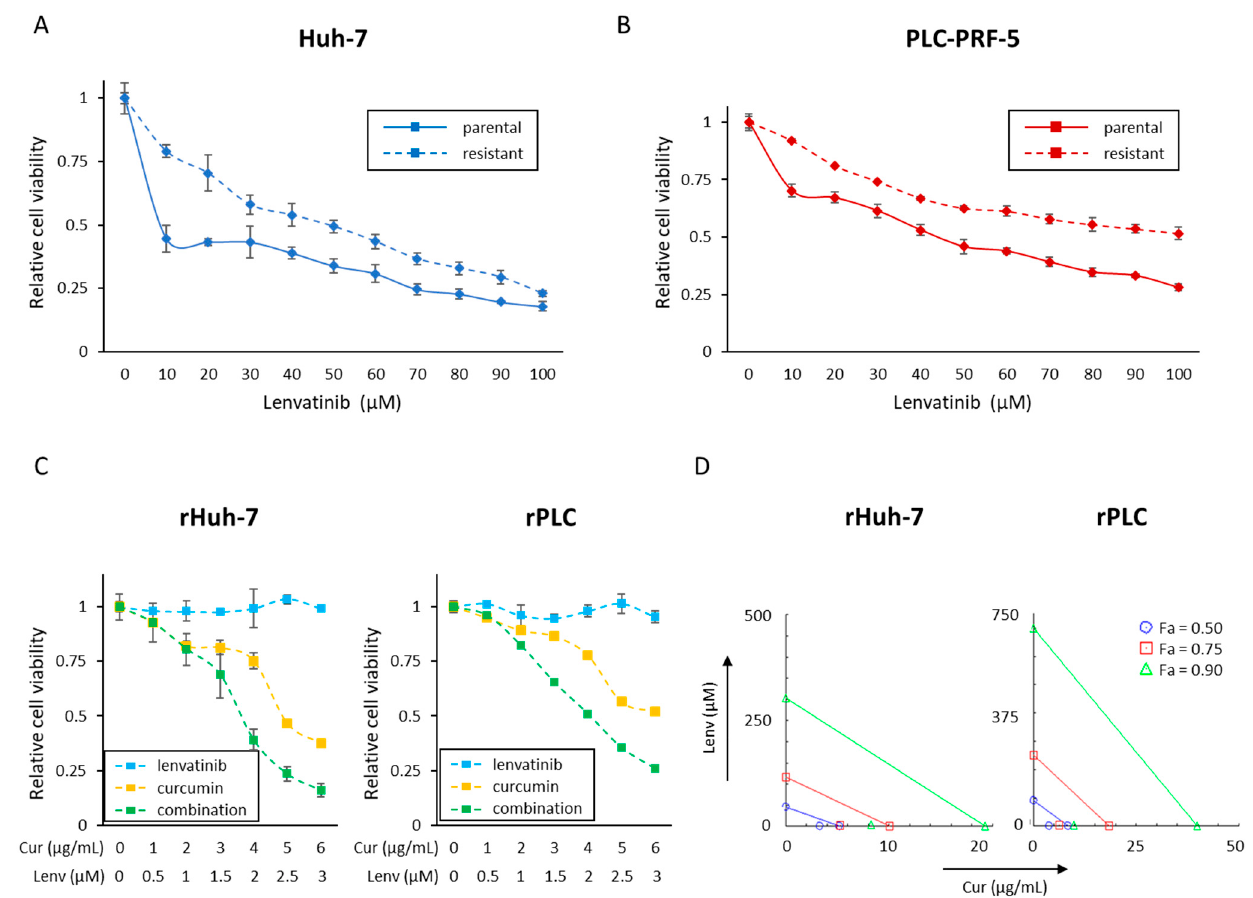
Figure 2. Curcumin reverses the acquired resistance to Lenvatinib in HCC cells. ( A , B ) Cell viability assay following Lenvatinib treatment for 48 h in parental and resistant cells of Huh ‐ 7 and PLC ‐ PRF ‐ 5 cells. ( C ) Cell viability assay following 48 h of Curcumin and Lenvatinib combination treatment in resistant Huh ‐ 7 and PLC ‐ PRF ‐ 5 cell lines. ( D ) Isobologram analysis of Curcumin and Lenvatinib combination in Huh ‐ 7 and PLC ‐ PRF ‐ 5 (Lenvatinib ‐ resistant) cell lines. Error bars in all panels represent the mean ± SD. SD, standard deviation.